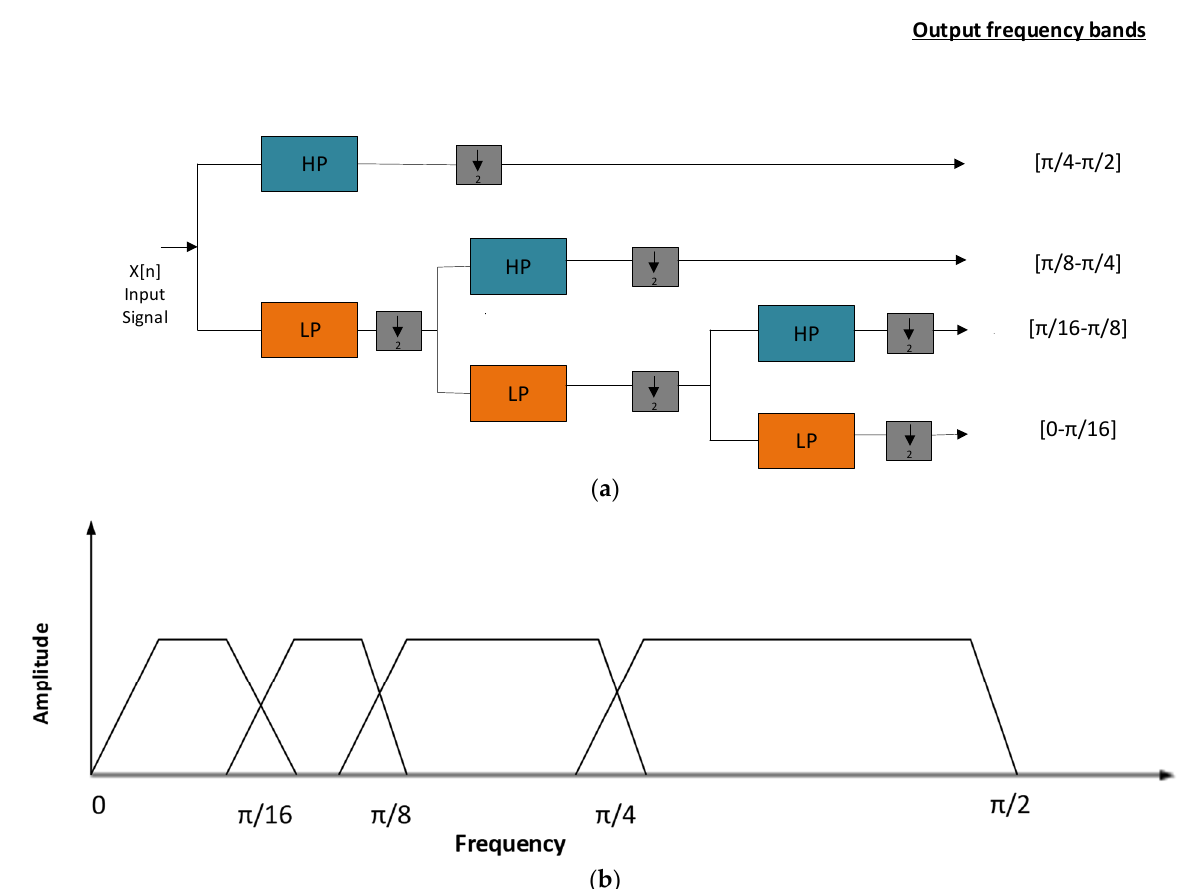
Figure 2. Proposed discrete wavelet transform (DWT): ( a ) HP and LP signal decomposition; ( b ) fre- quency bands of different bandwidths of a DWT.